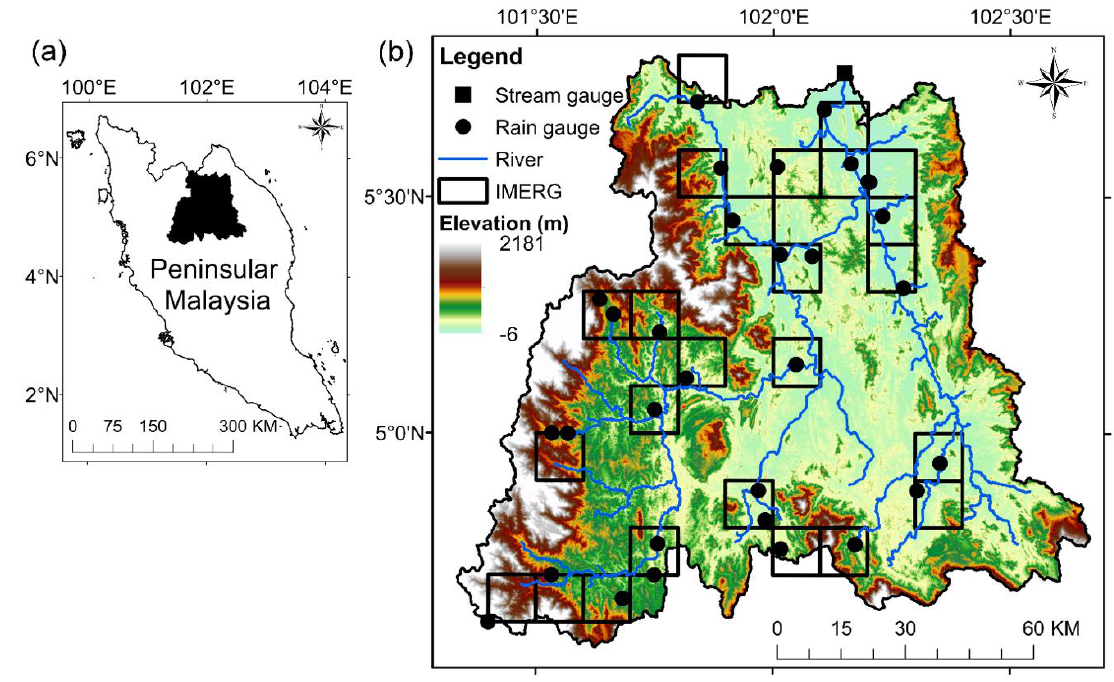
Figure 1. Maps of ( a ) Peninsular Malaysia and ( b ) Kelantan River Basin.